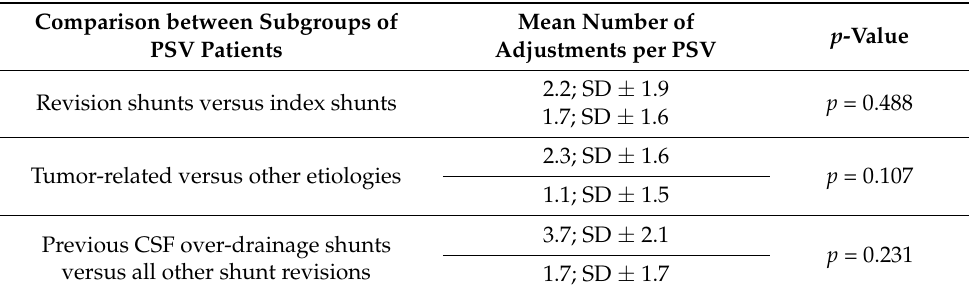
Table 3. Summary of comparison between subgroups of PSV